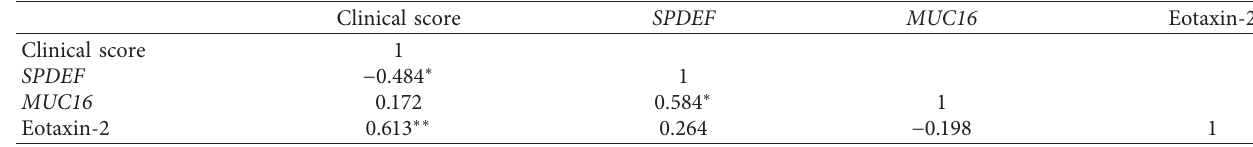
Figure 3: Messenger RNA expression levels of membrane-associated mucin in the stable and active groups. The expression levels of MUC1 (a), MUC4 (b), and MUC16 (c) mRNA showed no significant (NS) differences between the active and stable groups. Table 2: Partial correlation coefficients between gene expression levels and allergic conjunctival disease scores.